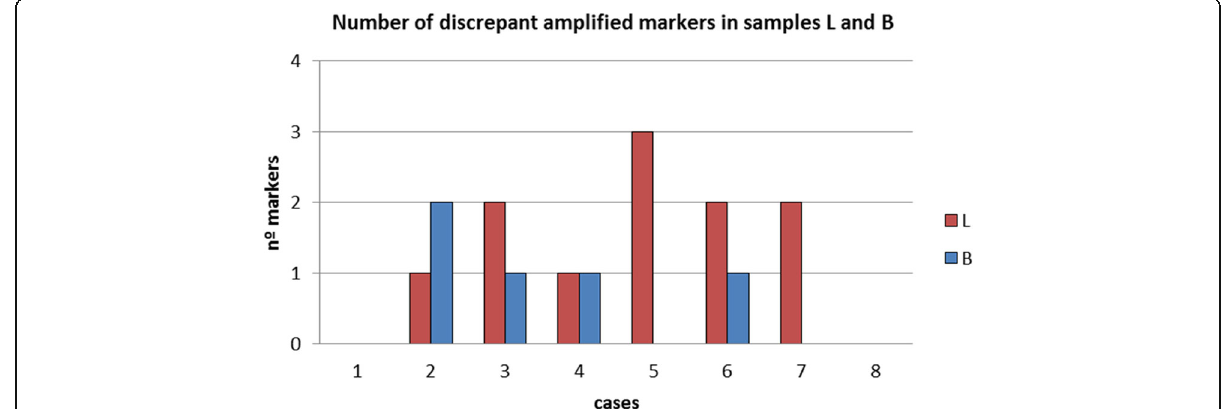
Fig. 4 Comparison between autosomal markers. The number of discrepant amplified autosomal markers, independent of contamination, samples L e